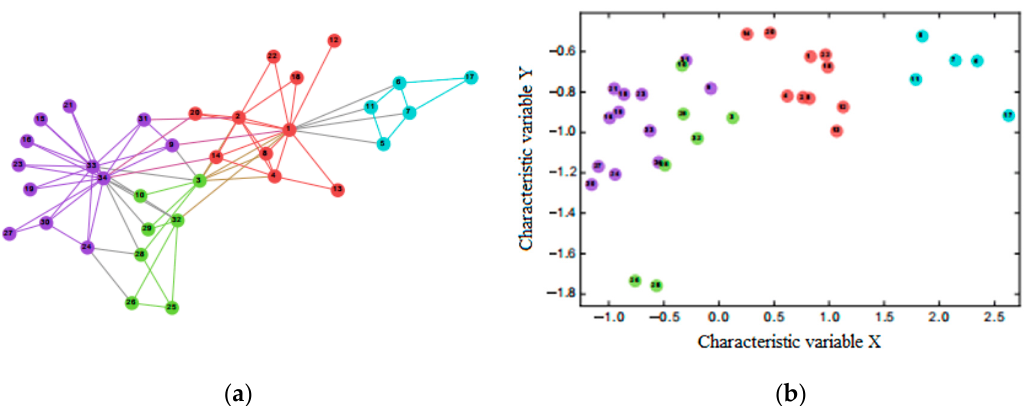
Figure 3. ( a ) Shows the layout of the karate club data. ( b ) Shows the distribution of the two potential dimensions output by DeepWalk in the coordinate system. The horizontal and vertical coordinates represent the eigenvalues of DeepWalk with an output of two